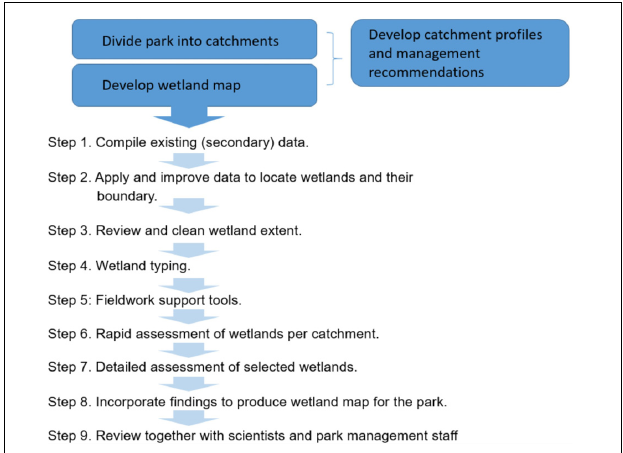
FIGURE 3 | Flow diagram of wetland inventory approach.